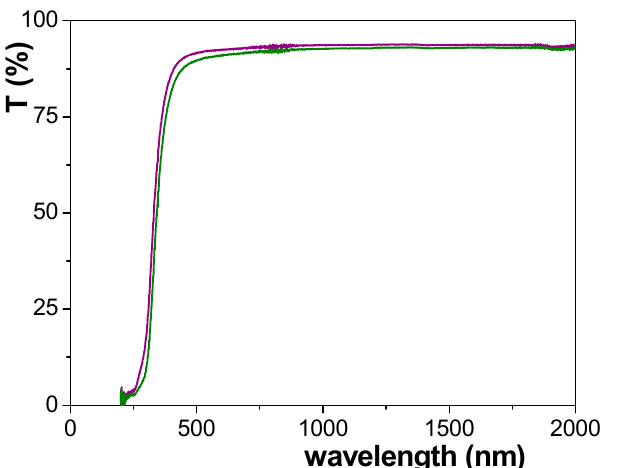
Figure 10. Transmission spectra for Ox–SiO 2 /APTES sample (green line) and Ox–SiO 2 /APTES/O 3 sample (purple line).